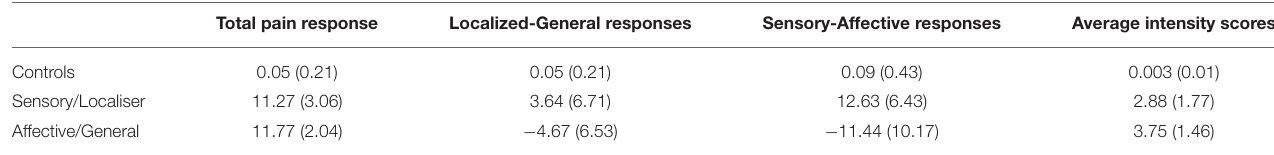
TABLE 1 | The characteristics of the three groups on the Vicarious Pain Questionnaire (VPQ) showing the mean (SD in parentheses) for the three dimensions used in the cluster analysis, together with mean intensity (0–10